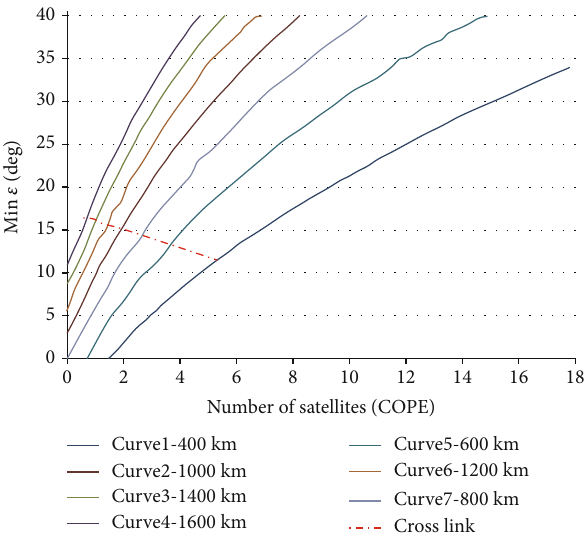
Figure 9: Results of polar COF